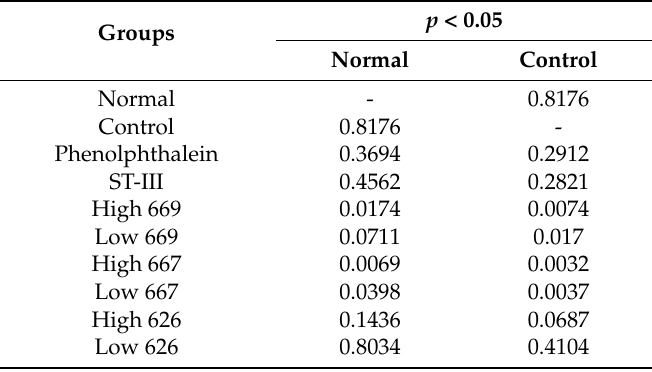
Table 4. Effect size of the changes in community structure.